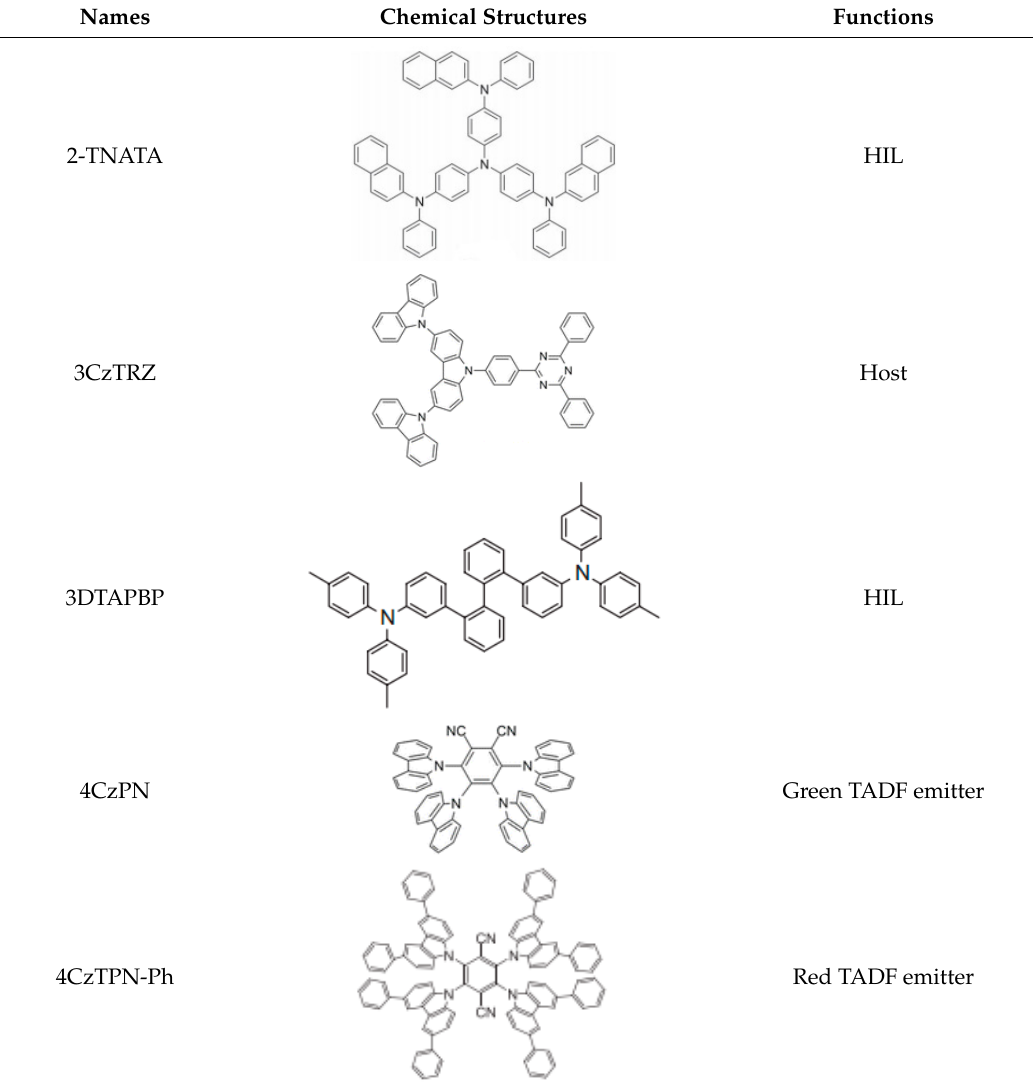
Table A1. Chemical structures of organic compounds as the emitters, hosts, and other part of WOLEDs discussed.